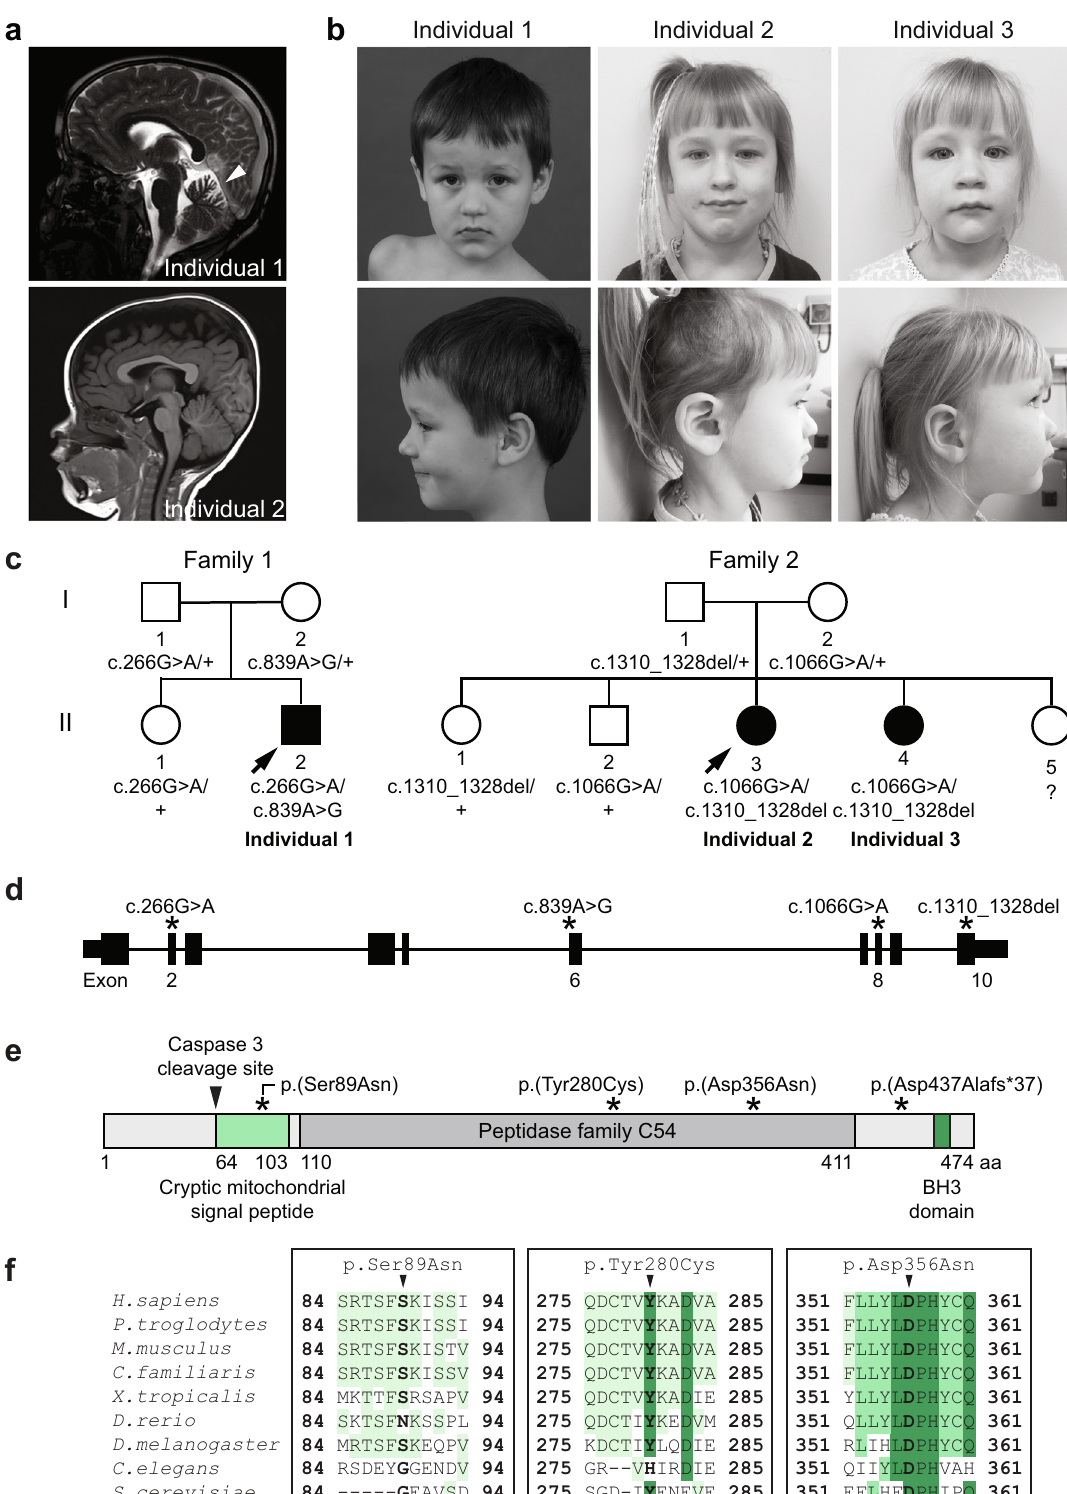
and NM_032885.5: c.1066G>A) and a deletion (NM_032885.5: c.1310_1328del) and were either predicted to lead to missense variants in functional domains of the protein or a frameshift variant (Fig. 1e and Supplementary Table 1). The Genome Aggregation Database (gnomAD) allele frequencies of the